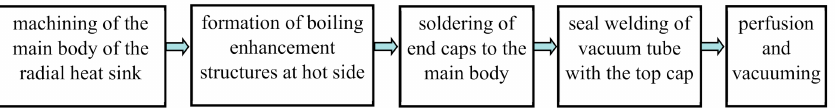
Figure 2. Fabrication process of the radial phase change heat sink.